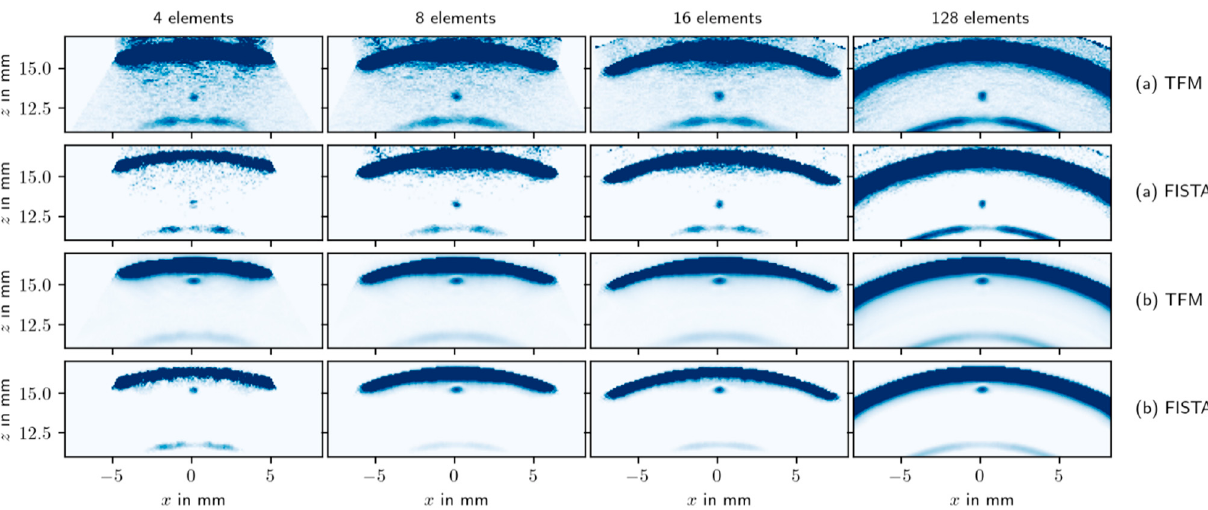
Figure 9. B-scan views of the reconstructions of data subject to additive white Gaussian noise normalized such that the maximum of the colormap of each image is the maximum value of the defect, where each column shows a different number of transmit elements. The rows indexed by ( a ), ( b ) have been calculated for a defect located at 𝑧 = 13 mm and 𝑧 = 15 mm , respectively.